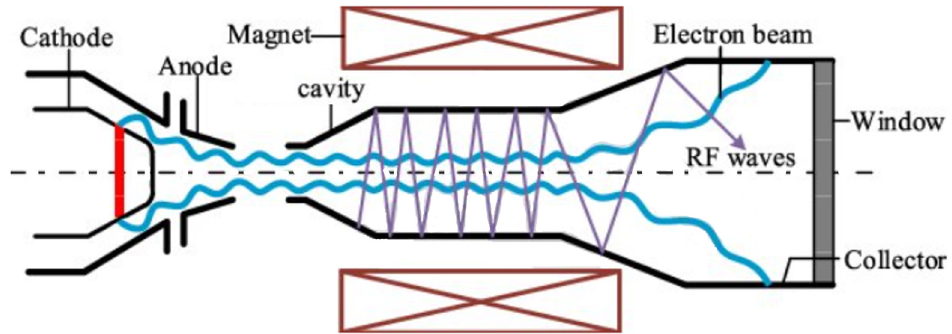
Figure 1. Schematic view of the interaction between the electron beam (blue solid line) and the electromagnetic wave in the resonator, producing the microwaves (in purple).